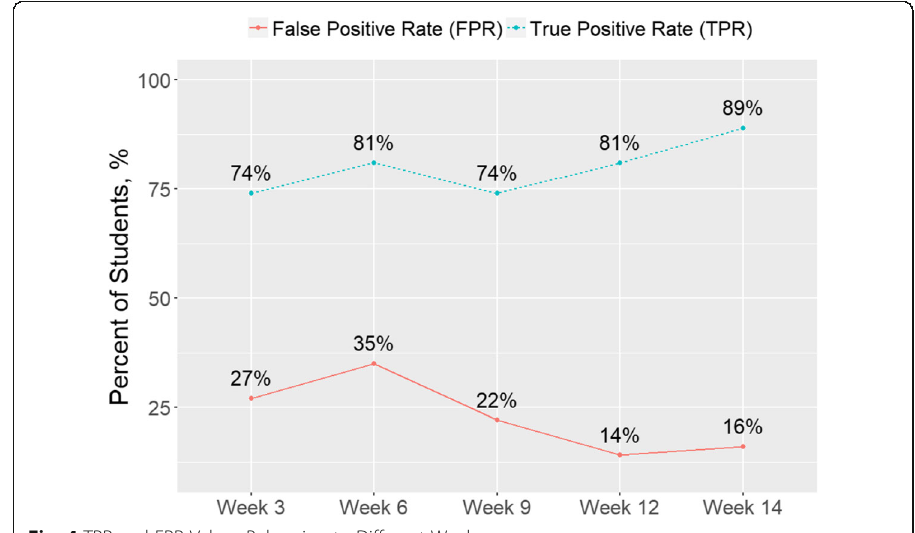
Fig. 4 TPR and FPR Values Belonging to Different